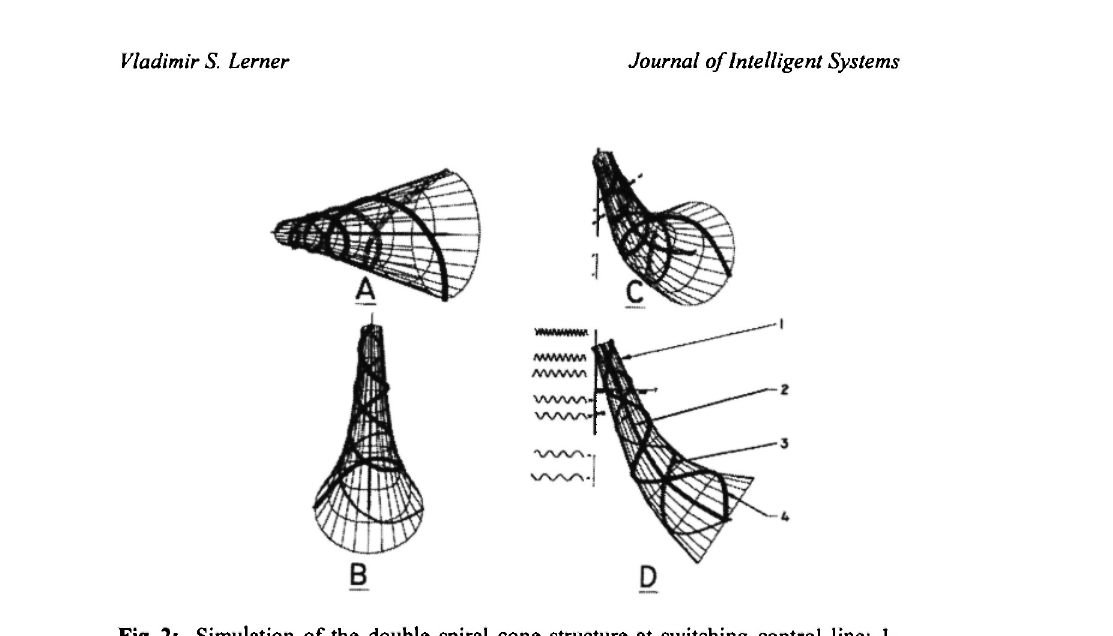
Fig. 2: Simulation of the double spiral cone structure at switching control line: 1- Surface of Uncertainty Zone (UR) surrounding the hyperbola; 2, representing the L-line of switching control; 3, 4-the double spirals on the UR surface; (a) view from the top; (b) front view; (c) isometric view, (d) view from the right